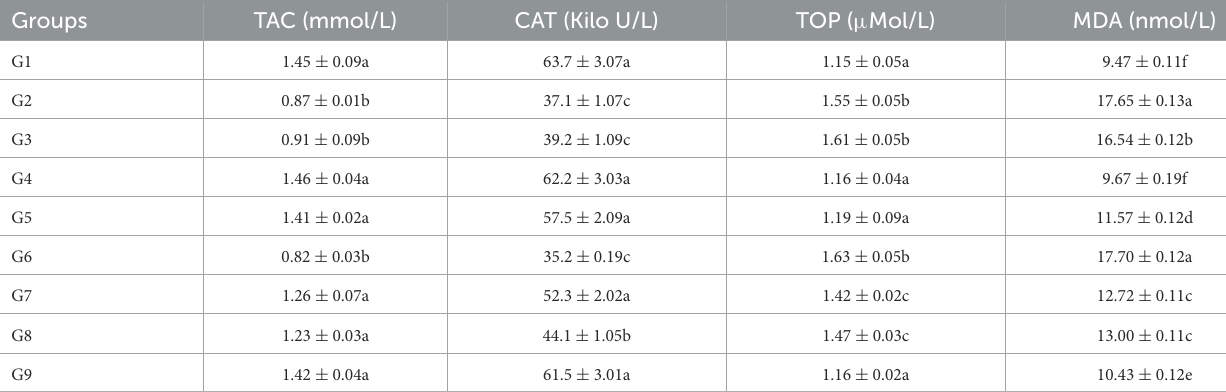
TABLE 6 Antioxidant enzymes/parameters (TAC and CAT) and oxidant enzymes (TOC and MDA) in broiler chicks on day 21 experiment administered arsenic, chromium, vitamin E, and bentonite alone or in combinations.